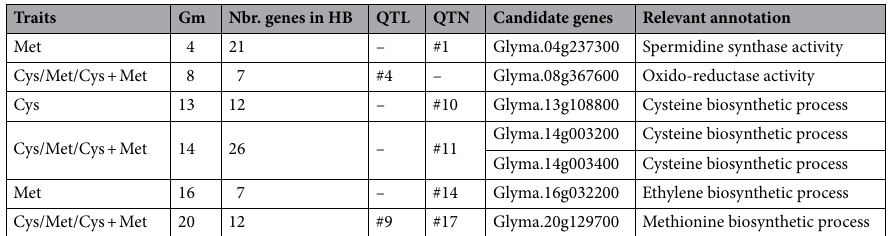
Traits Gm Nbr. genes in HB QTL QTN Candidate genes Relevant